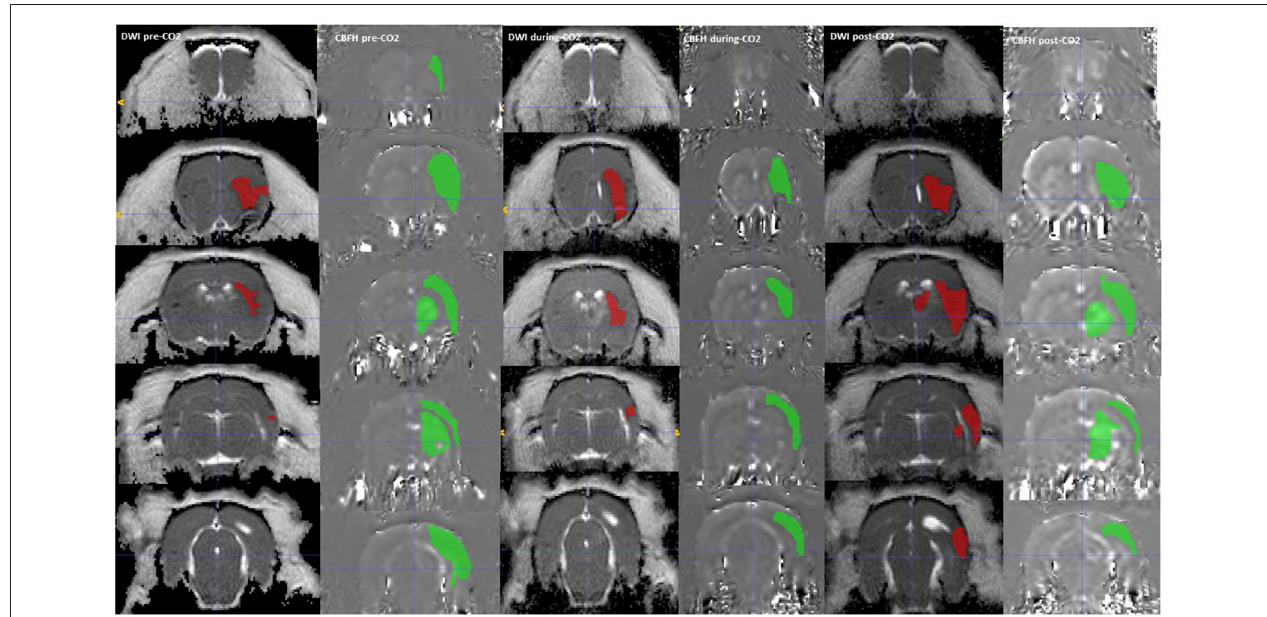
TABLE 2 | Changes in cerebral blood flow hypoperfusion (CBFH)/hemisphere volume: 6 and 12% carbon dioxide (CO 2 ) groups versus control groups. Control group 6% CO 2 group 95% CI, P-value 12% CO 2 groupMean (SD) 95%, P -value Mean (SD) Mean (SD) Pre CO 2 vs. during CO 2 − 0.004 (0.009) 0.079 (0.412) − 1.59 to 0.186, P = 0.853 0.0094 (0.141) 0.034 to 0.133, P = 0.004 During CO 2 vs. post CO 2 0.03 (0.029) 0.074 (0.049) − 0.491 to 0.137, P = 0.291 0.283 (0.056) − 0.124 to 0.120, P =